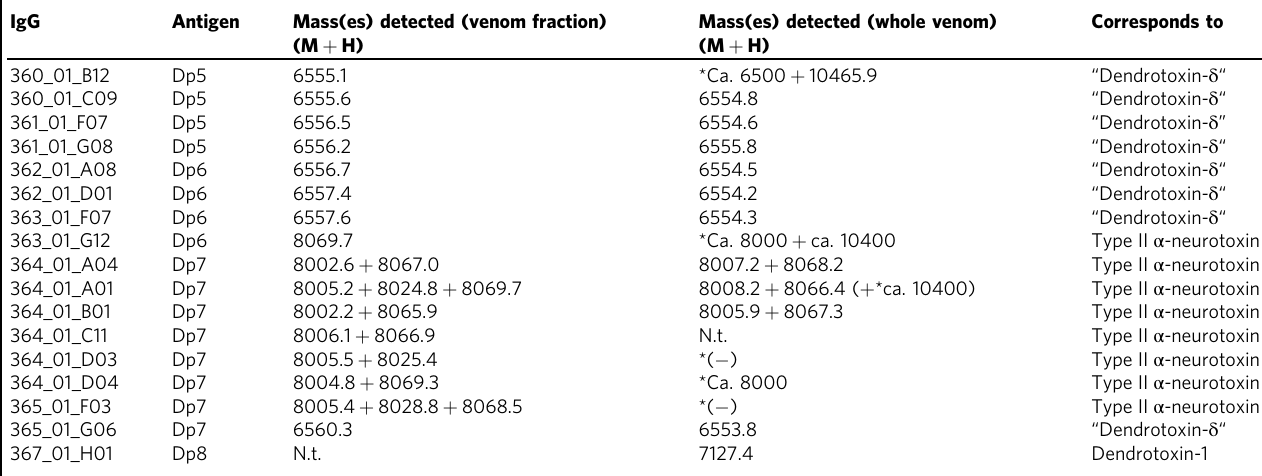
Mass(es) detected (whole venom) (M + H)